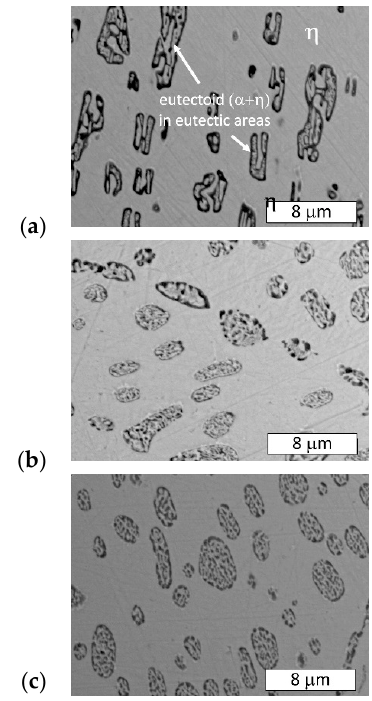
Figure 4. Microstructure of Zn-4Al alloy after heat treatment at 300 °C : ( a ) furnace-cooled, ( b ) air-cooled, ( c ) water-quenched. The visible morphology of the eutectic structure was not affected by the eutectoid transformation. Etched with Nital. Light Microscopy.